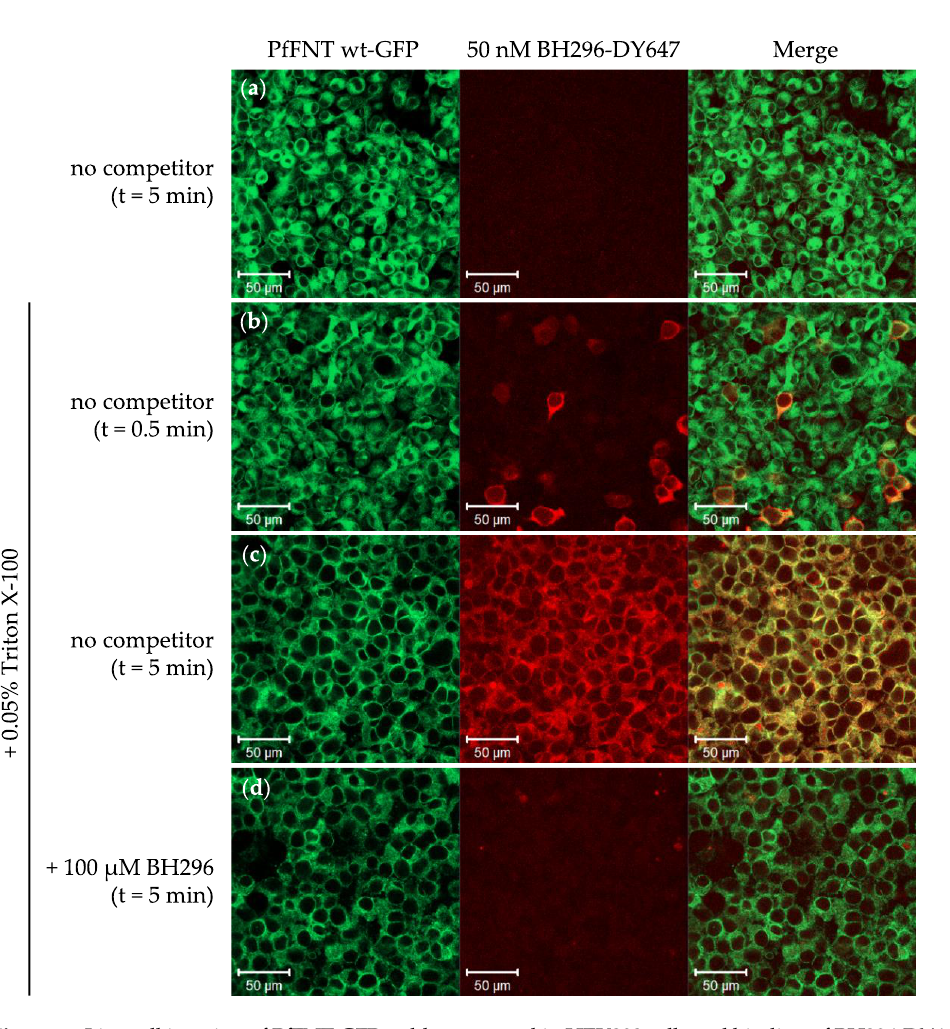
Figure 2. Live cell imaging of PfFNT-GFP stably expressed in HEK293 cells and binding of BH296-DY647. Representative images of PfFNT-GFP fusions (green, left panels) and BH296-DY647 (red, middle panels) are shown. ( a ) No co-localization of PfFNT-GFP and BH296-DY647 was observed in the absence of Triton X-100. Co-localization was clearly visible after treating the cells with 0.05% Triton X-100 for membrane permeabilization. After 30 s of incubation ( b , merged images, co-locali- zation in yellow, right panels), membrane localization of BH296-DY647 was clearly visible and in- creased over time ( c , incubation time 5 min). ( d ) Preincubation with 100 µM of unlabeled BH296 prevented binding of the labeled tracer, indicating that co-localization is mediated by interaction with PfFNT-GFP. BH296-DY647 was added at a concentration of 50 nM to cultured HEK cells stably expressing PfFNT-GFP to test for co-localization of the compound with the target at the plasma membrane by confocal imaging. However, even after incubation for 1 h, binding of labeled BH296 could not be observed (Figure 2a). As the cytoplasmic domain of the transporter is inaccessible for the compound, we next explored possibilities to permea- bilize the plasma membrane and to retain cell viability for the time of incubation. For this, we used Triton X-100 at a final concentration of 0.05%, as described previously [16] to allow for diffusion of compounds into the cell. In the presence of Triton X-100, membrane localization of BH296-DY647 was clearly visible after 0.5 min incubation, and the intensity of staining increased within 5 min (Figure 2b,c). A prolonged incubation was impeded by incipient cell disintegration and membrane blebbing. We next set out to test the specificity of binding by analyzing the interaction of labeled BH296 with its unlabeled parental com- pound. As shown in Figure 2d, preincubation of cells with an excess of 100 µM of BH296 completely abrogated binding of the labeled inhibitor.